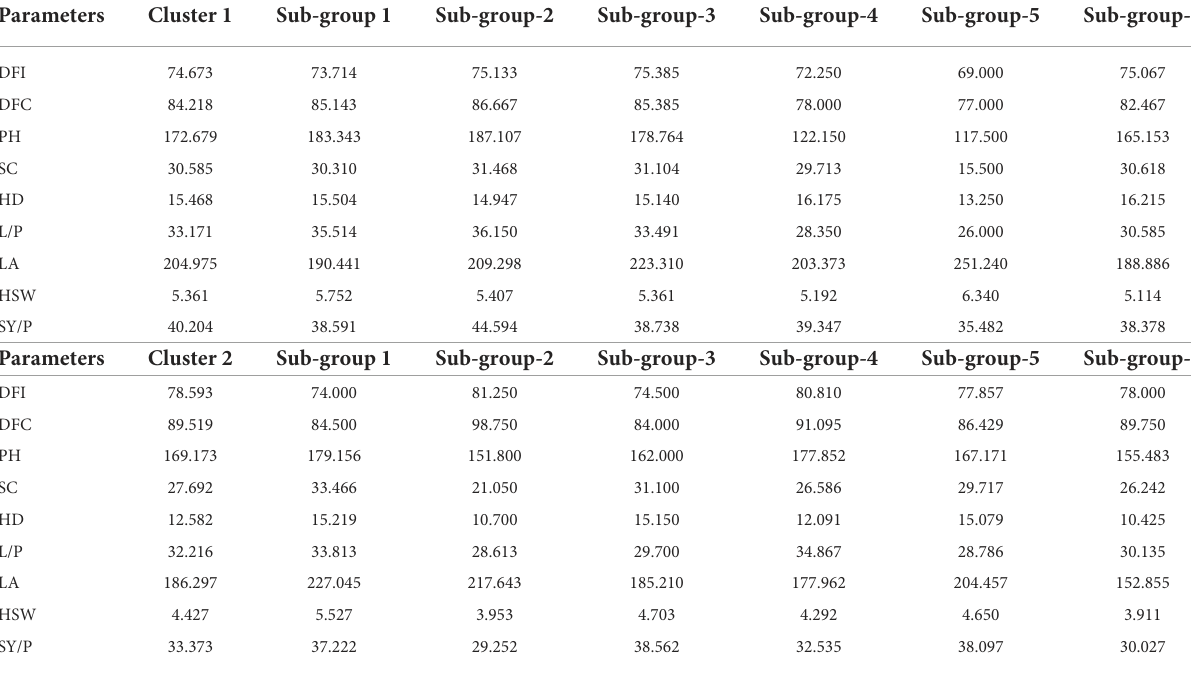
TABLE 2 Mean values of clusters and sub-groups for dendrogram constructed based on nine morphological